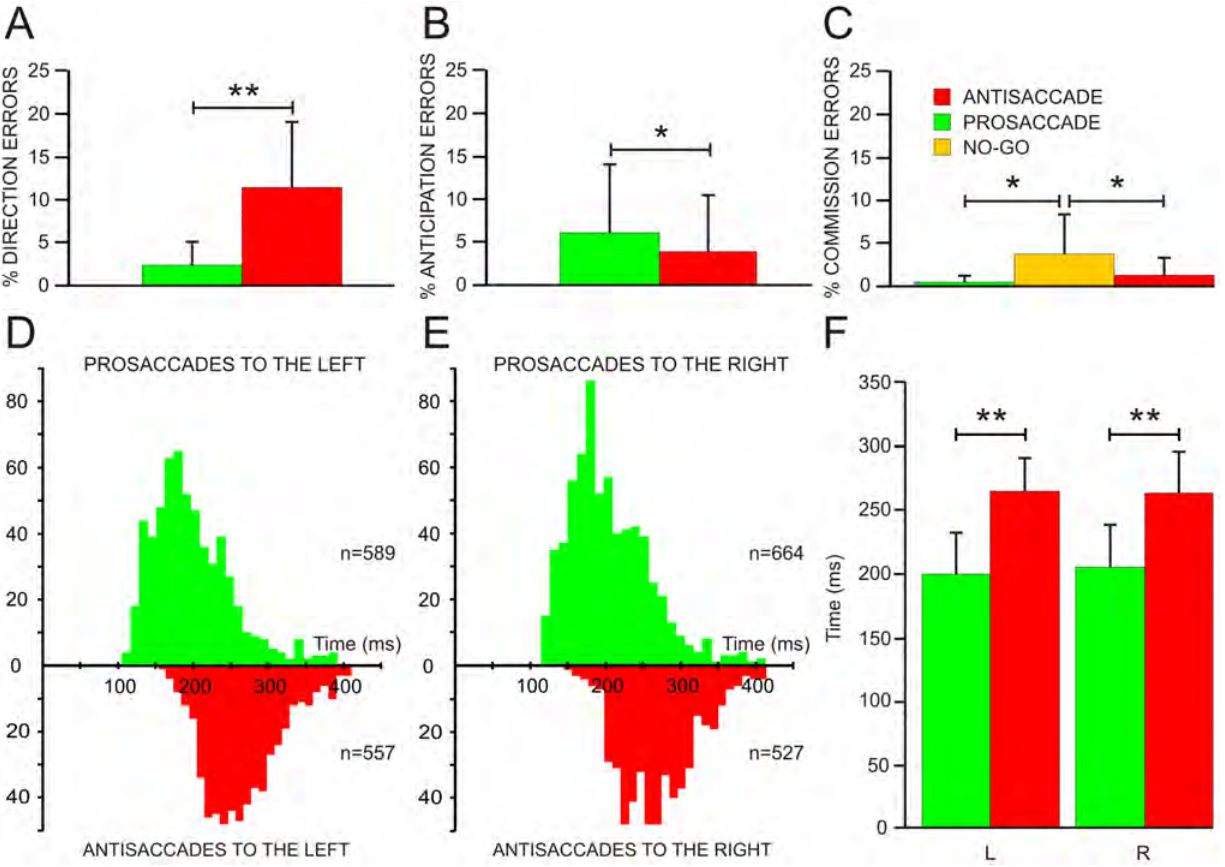
Figure 2. Errors of execution and saccadic latencies of prosaccadic and antisaccadic eye movements. Percentage of direction (A), anticipation (B) and commission (C) errors during prosaccadic (green), antisaccadic (red) and no-go (yellow) tasks. In D and E, histograms of saccadic latencies for prosaccades (up, green) and antisaccades (down, red) directed to the left (D) and to the right (E). In F, mean saccadic latencies and standard deviation for prosaccadic and antisaccadic eye movements directed to the left (L) and to the right (R). The asterisks indicate significance of differences: *p , 0.05, **p , 0.01.